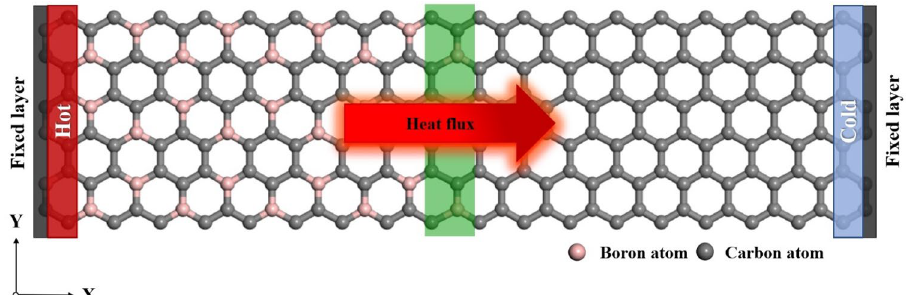
Figure 3. MD setup for evaluating thermal properties of BC 3 GrHs. Gray and pink balls denote carbon and boron atoms, respectively. The periodic boundary condition is applied along the X and Y directions. The heat flux is in the X-direction. The green, red, and blue regions show the grain boundary, hot slab, and cold slab, respectively. The visualization was obtained by means of visual MD (VMD) simulation (Ver. 1.9.3, https:// www. ks. uiuc. edu/ Devel opment/ Downl oad/ downl oad. cgi? Packa geName=